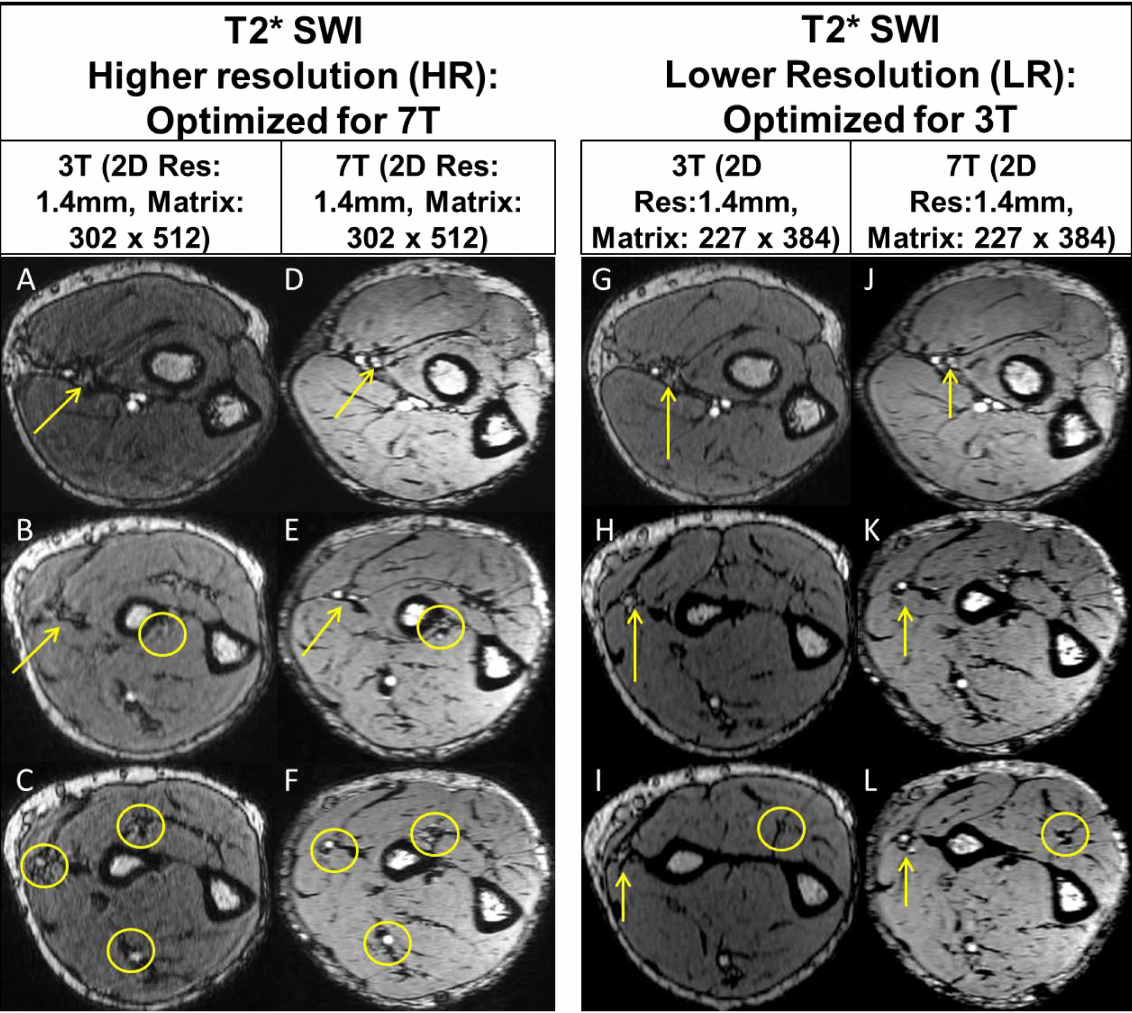
Fig 4. 3T/7T T2 * SWI: Intramuscular vascular branches [off the radial artery] are shown on the HR/LR 3T [A, B, C, G, H and I] images, but are more delineated on 7T [D, E, F, J, K and L] images. Yellow arrow and circles: indicate micro-vessel branches. Out of all three volunteer,the above data is from single